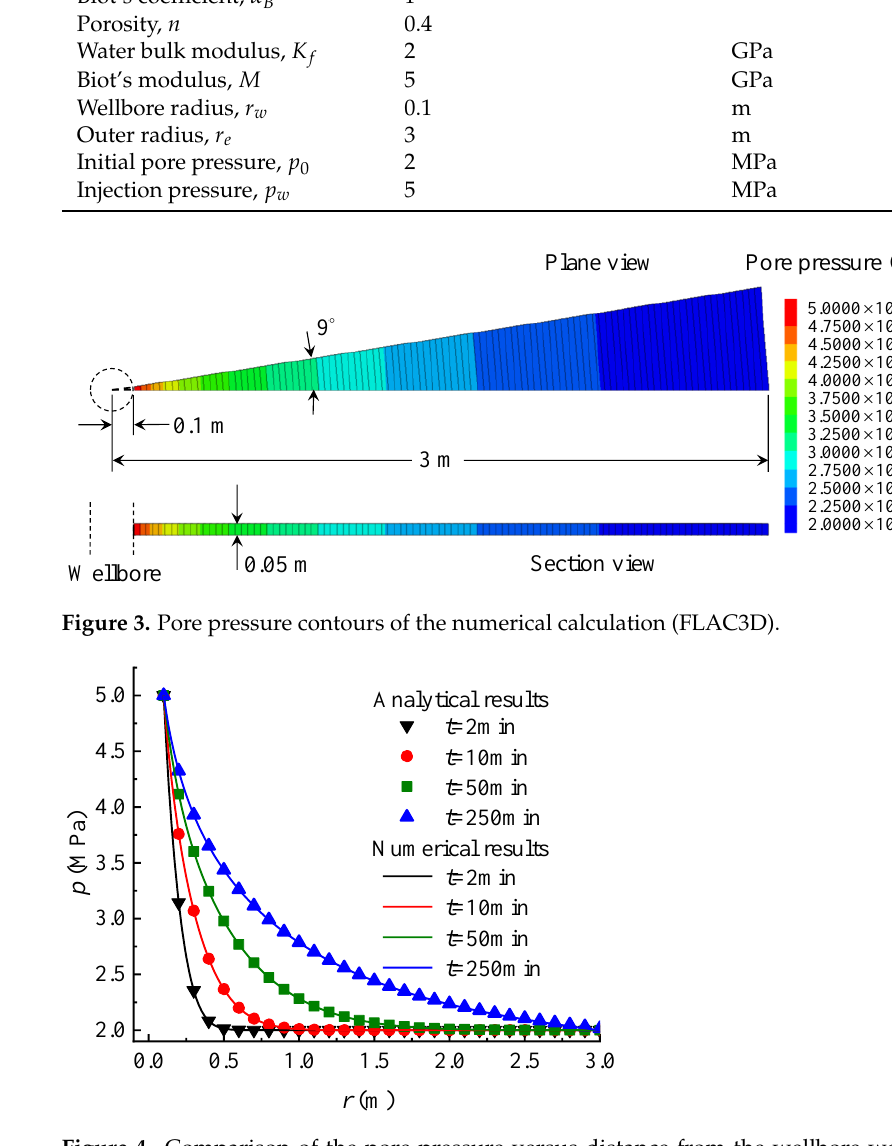
Figure 5. Comparison of the seepage force versus distance from the wellbore wall between the ana- lytical and numerical results (FLAC3D) for various times. The applicability of the proposed seepage model in practice engineering is validated by comparing it with the numerical results in previous work [44]. Sun et al. (2018)